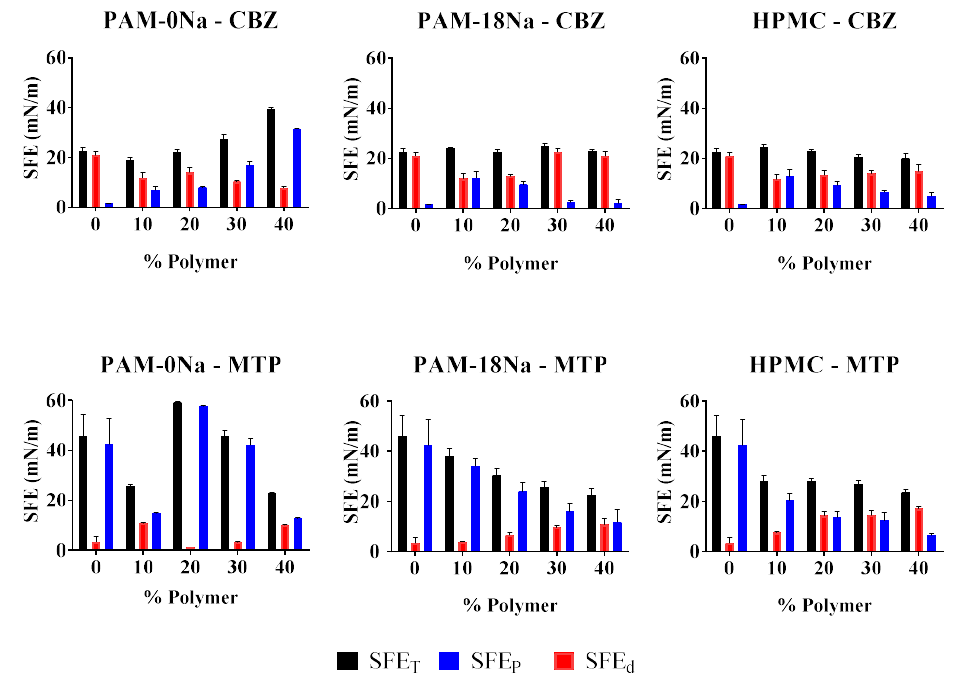
Figure 4. Surface Free Energy-SFE for tablets elaborated with CBZ and MTP and different proportions of the PAM-0Na, PAM-18Na and HPMC polymers.